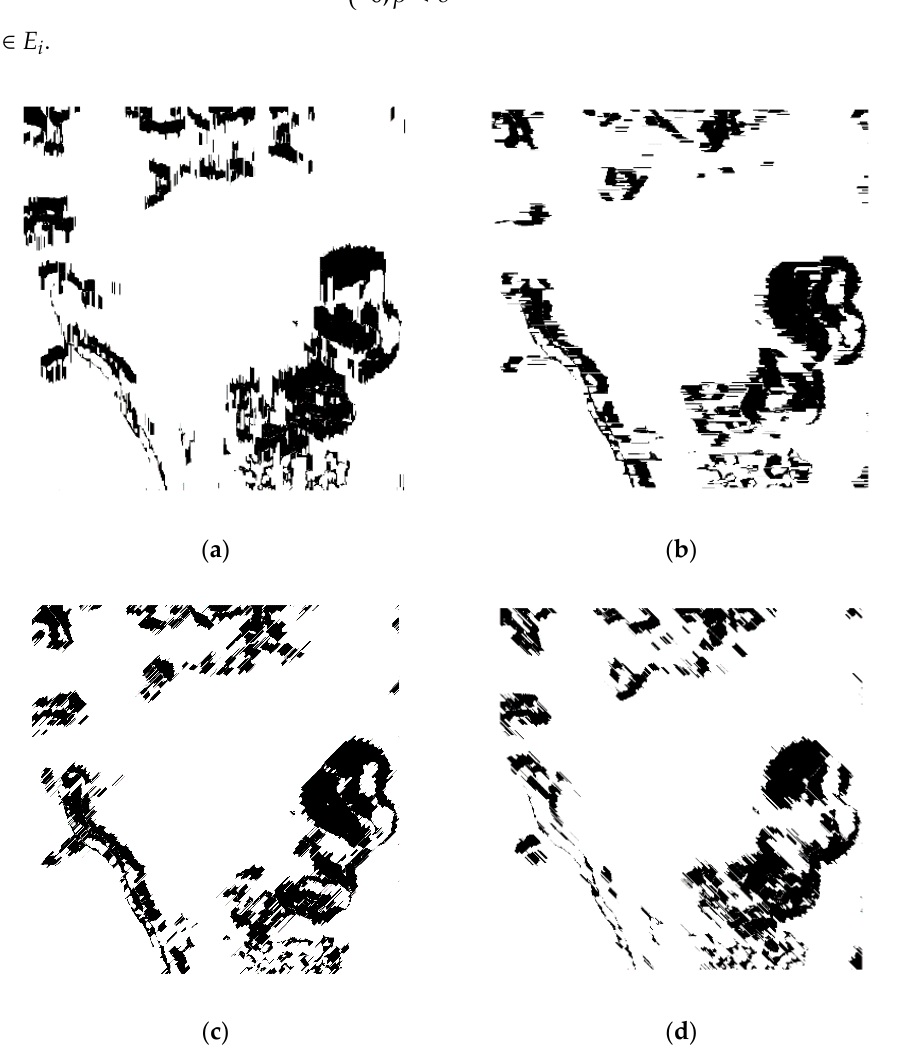
Figure 4. Schematic diagram of four direction scanning binary map. ( a ) is the vertical scanning map; ( b ) is the horizontal scanning map; ( c ) is the 45° left scanning map; ( d ) is the 45° right scanning map.